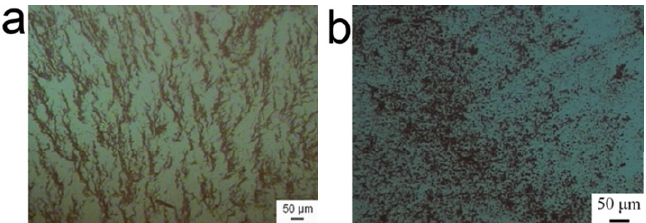
O nanoparticles aggregates without the 2 3